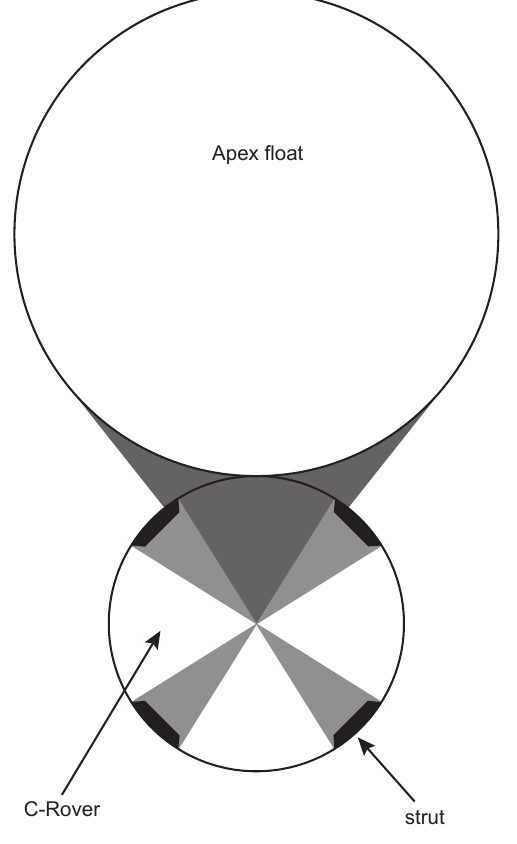
Fig. 10. Schematic showing cross section (in x - y plane) of APEX float body and adjacent C-Rover transmissometer. Dark-gray area shows shading of the transmissometer by the float body, and light- gray areas show shading of the transmissometer by its four support struts. The unshaded fraction of the transmissometer circumference is 53.4%.